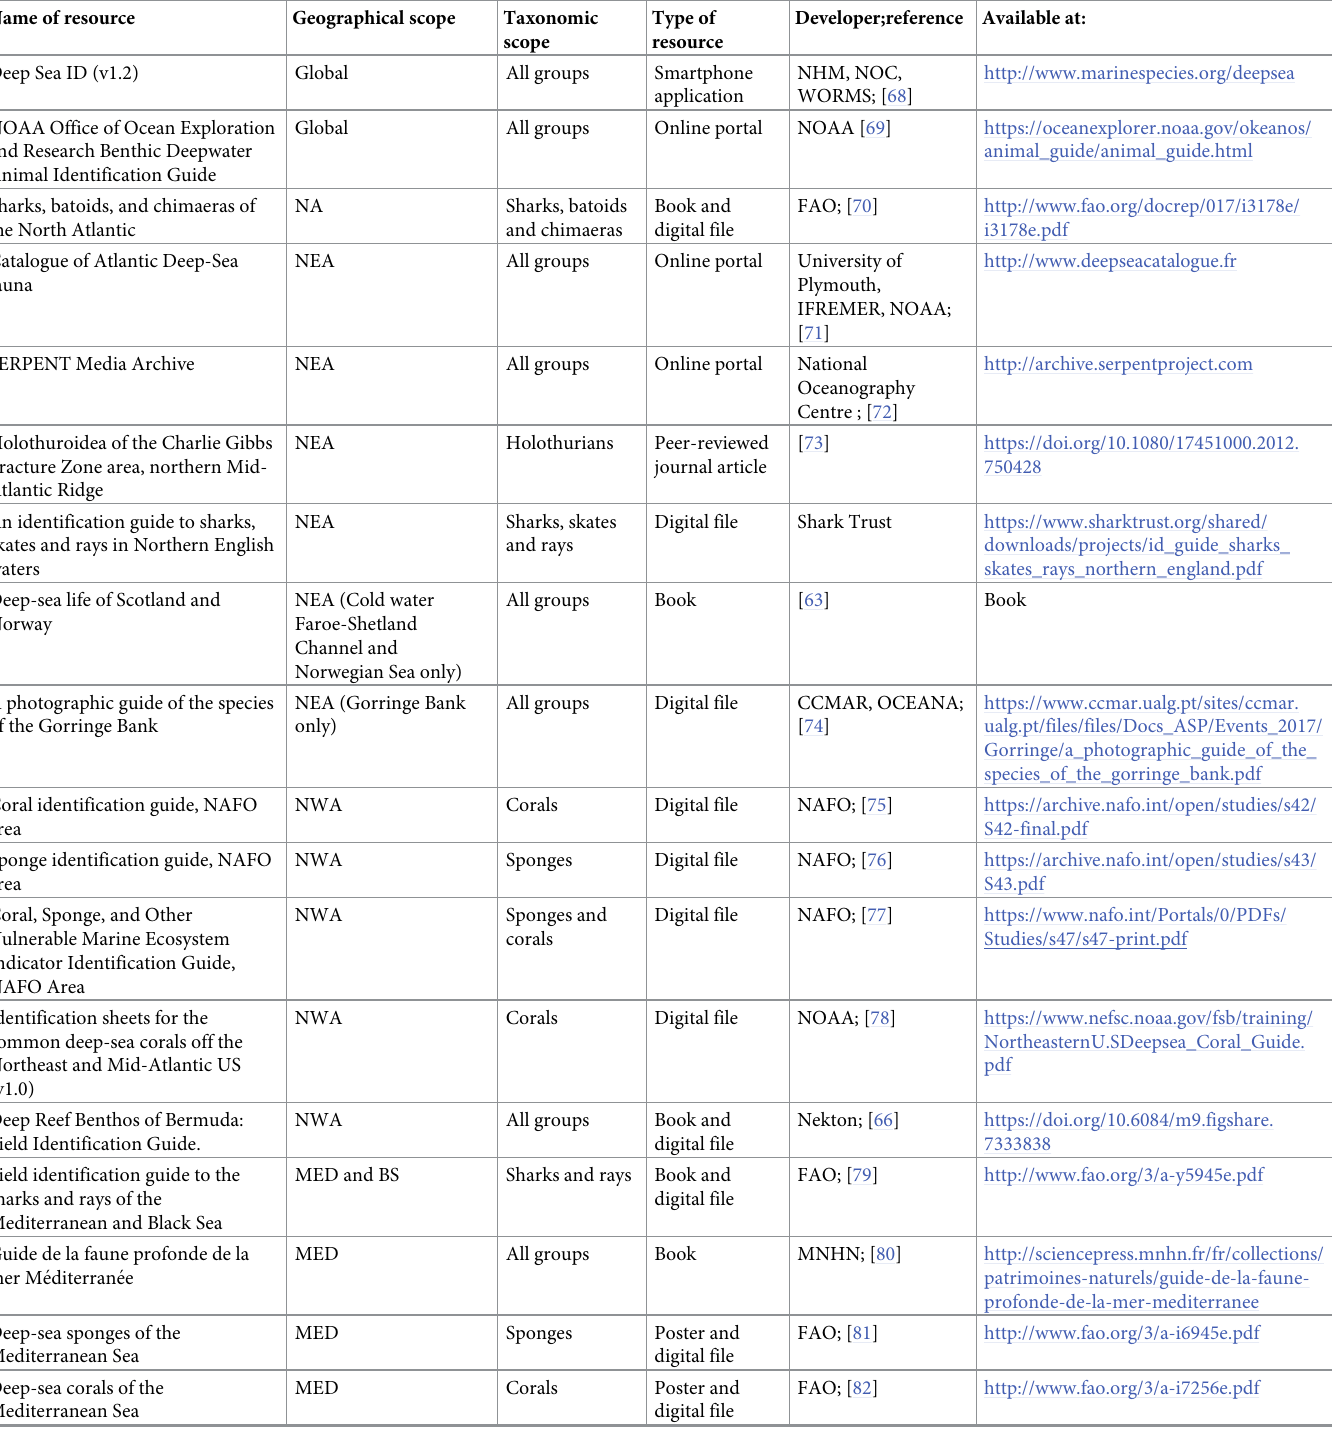
Table 1. List of available image catalogues and identification guides of the deep-sea fauna off the Atlanto-Mediterranean region. Name of